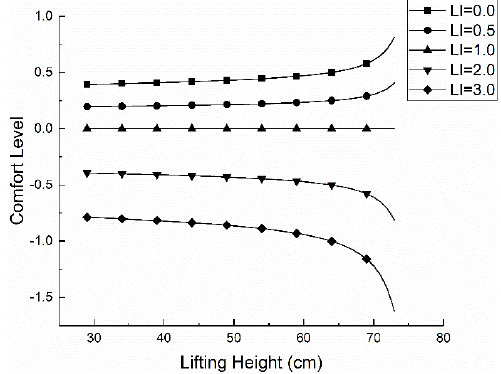
Figure 8. The relationship between C and h .